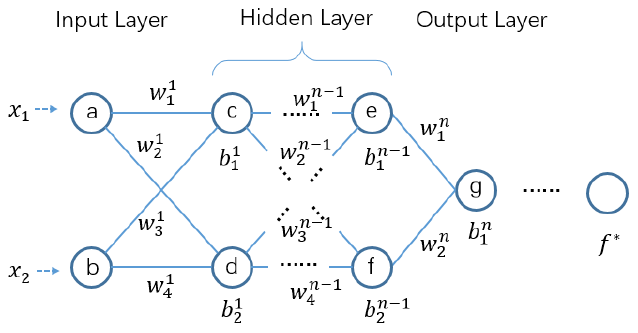
Figure 3. Multi-layer perceptron model.